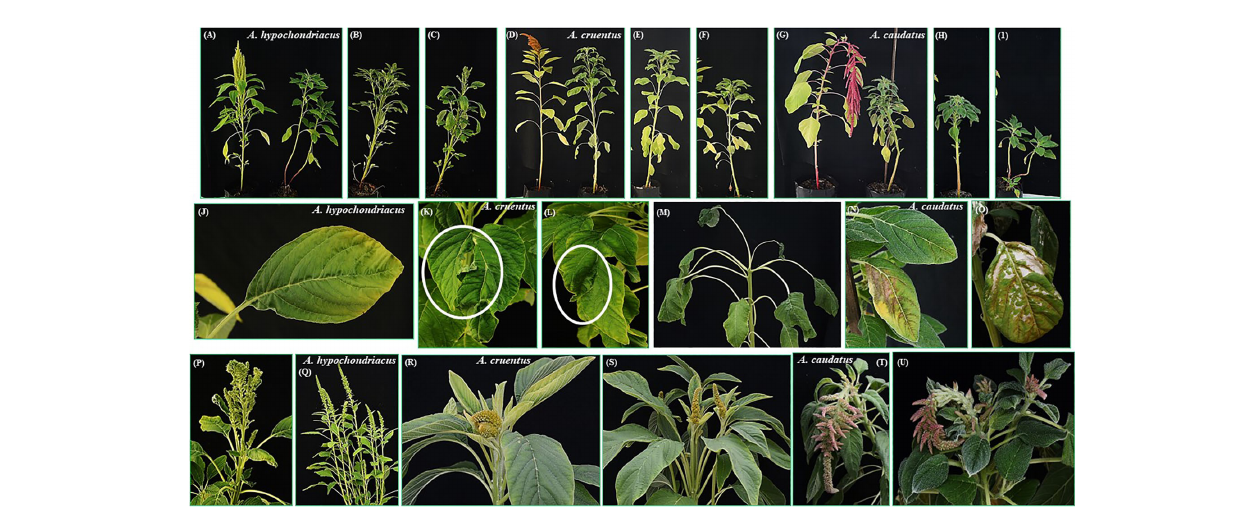
FIGURE 6 Effects of prolonged, severe heat stress on vegetative and reproductive development in grain amaranth plants. Severe long-term heat stress stunted plant growth, leading to plants that were, in average 1.5 to 2-fold shorter than control plants kept under optimal conditions (A – I) . Some heat-stressed plants rami fi ed into two-stemmed plants, as shown in A. hypochondriacus (A) and A. caudatus (I) ; Heat stress conditions caused leaf damage in A. caudatus (J, N, O) , or led to a morphological alteration characterized by the division of the leaf into two parts along the middle of the leaf surface (K, L) . Panicle emergence was greatly delayed or suppressed (i.e., in A. cruentus ) (M) , and subsequent development was very slow (i.e., in A. cruentus ) (R) or produced deformed panicles (i.e., in A. hypochondriacus ) (P) . Flowering in the panicles produced by A. cruentus and A. caudatus was also delayed (R, U) , whereas fl owering panicles (i.e., in A. hypochondriacus (Q) and A. cruentus ) produced very low numbers of immature/mature seeds, or no seeds at all ( A. caudatus ). Heat stress also led to profuse branching, a modi fi cation that occurred concomitantly with panicle emergence in most plants of the three grain amaranth 3 species (Q – U)